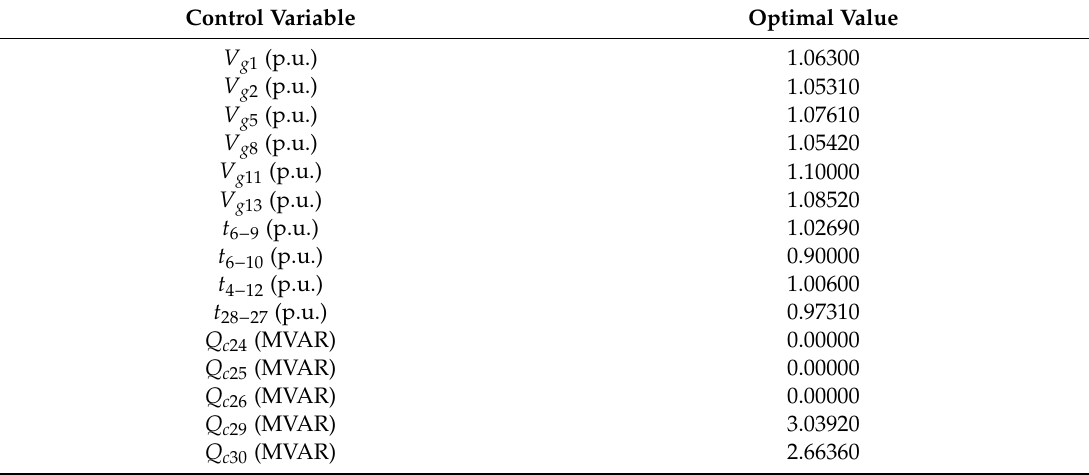
Table 8. The optimal values of the control variables for the deterministic multi-objective RPP considering the loadability